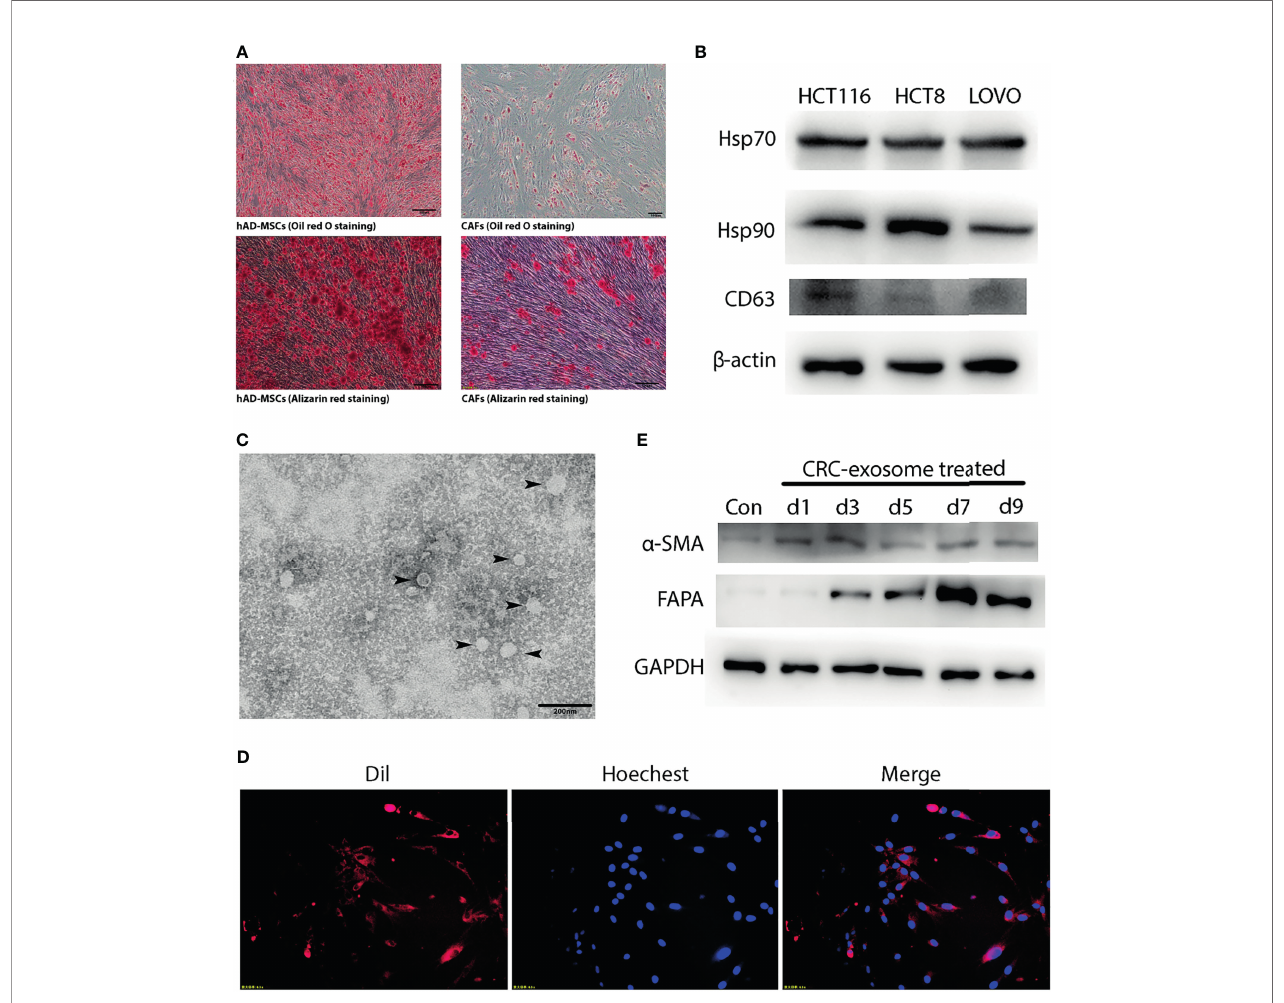
FIGURE 1 | CRC-exosomes induced differentiation of hAD-MSCs into CAFs. (A) Comparison of adipogenic (Oil red O staining, day11) and osteogenic (Alizarin red staining, day14) differentiation ability between hAD-MSCs and CAFs. (B) Detection of CRC-exosomes speci fi c marker proteins by Western Blot. (C) Ultrastructure of exosomes (black arrows) puri fi ed from HCT116 under TEM. (D) Exosomes from HCT116 (Dil-labeled) ingested by hAD-MSCs were veri fi ed with fl uorescence microscopy after incubating for 4 hours. Red: Exosomes (Dil). Blue: Nucleus (Hoechst 33342). (E) Western Blot analysis showed that the expression of CAFs-speci fi c proteins was upregulated after induction with